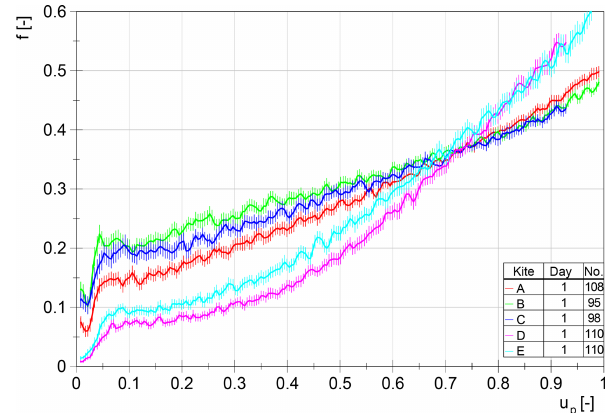
Figure 17. Force ratio between steering lines and the power line with resulting error ( P =